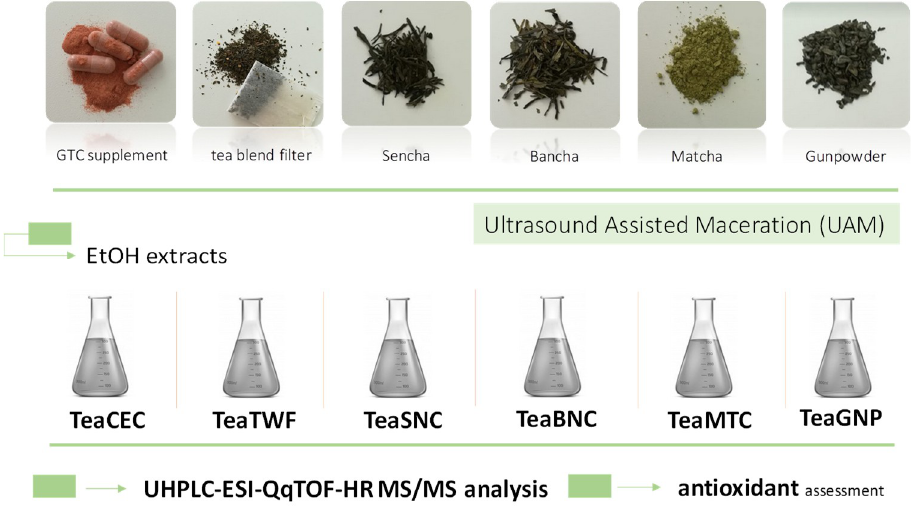
Figure 1. Extraction scheme applied on selected green tea matrices.